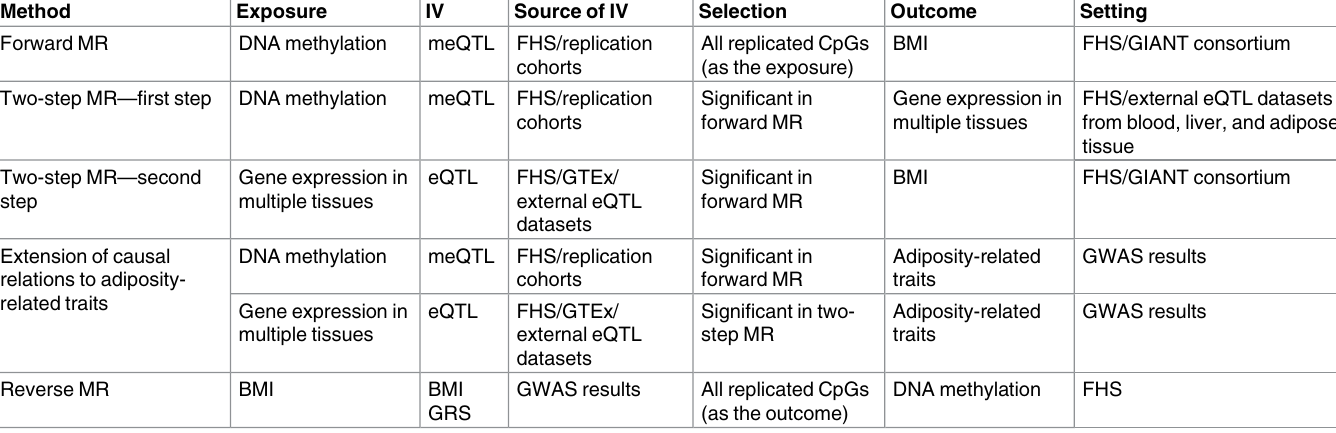
Table 1. Schema of instrumental variable analysesconducted in order to infer the potential causal relations between DNA methylation, gene expression, BMI, and adiposity-related